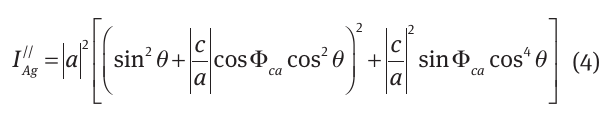
where Φ refers to the phase difference between the ca complex Raman tensor elements c and a . From (4), we can see that the polarized Raman intensity profile is a function of | c / a | and Φ . Whether the axis is parallel to the zigzag ca direction or the armchair direction is determined by | c / a | > 1 or | c / a | < 1. Typically, the measured angle-resolved intensity of vibrational mode is plot in the polar coordina- tion, and thus the twofold or the fourfold rotational sym- metry might be observed. In the experimental measurement, the angle-resolved polarized Raman spectroscopy not only relates to the ani- sotropy of 2DLMs, but also the measurement configura- tion. According to the angle between the polarization of incident and scattered light, there are three different con- figurations: only the incident light (P ); the incident light I is parallel to the scattered light (P // P ), and the incident I S ⊥ P light is perpendicular to the scattered light (P ). Here, I S P and P represent the polarizations of incident light and I S scattered light, respectively. The polarized Raman spectra of BP samples under the parallel configuration (the case of P // P ) at 633 nm are I S shown in Figure 2A, with the angle of 0 ° –180 ° [93]. Here, by taking the HRTEM images, the zigzag direction of BP is figured out paralleling to the incident light polarization of 0 ° . Three typical Raman peaks corresponding to 1 , A g B , and 2 A modes are observed at 361, 438, and 466 cm −1 , 2g g respectively. The minimum intensity of B mode shows a 2g change period of 90 ° , in which the angles at 0 ° and 90 ° are aligned with the armchair and the zigzag directions. From the obtained results, for a given thickness of BP sample, we can use the angle-resolved polarized Raman spectro- scopy to figure out the crystal orientation. The polarized Raman spectra of a 328-nm-thick ReS sample under the parallel configuration (P // P ) at 2 I S 532 nm are plotted in Figure 2B, showing that the V-mode at ~ 212 cm −1 changes periodically from 0 ° to 360 ° [94]. By extracting the angular-dependent Raman intensity at V-mode, we can obtain the twofold symmetry in polar plots. The direction of the maximum V mode intensity at 0 ° is aligned with the b-axis of exfoliated ReS 2